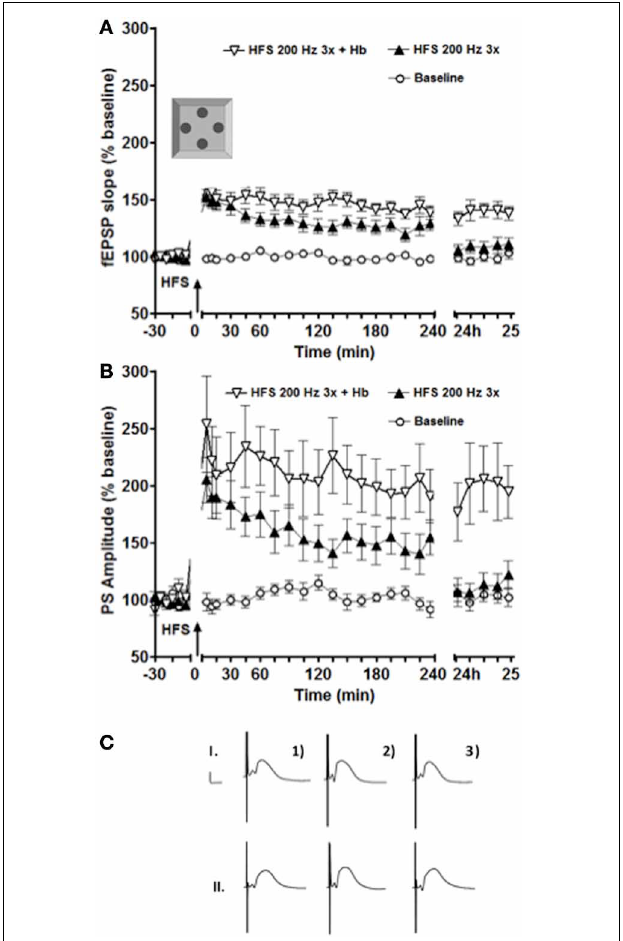
FIGURE 1 | Exposure to a novel holeboard (Hb) combined with a simultaneous HFS at 200Hz (3 bursts of 15 stimuli) resulted in a significant facilitation of both fEPSP (A) and PS (B) LTP in the intermediate DG ( n = 16). ANOVA revealed a significant difference between the sets of data collected in the experiments with and without holeboard exposure at 24h after the stimulation onset. (C) Shows examples of analog recordings of intermediate DG potentials with (II) and without (I) novel Holeboard exposure 5min before (1), 5min after (2), and 24h after (3) the HFS. Vertical bar: 5mV, horizontal bar: